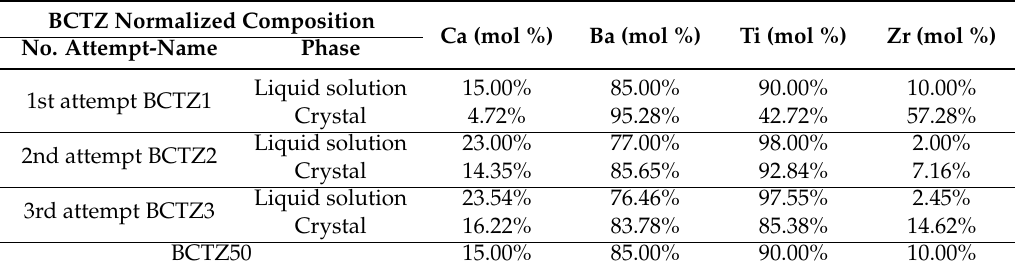
Table 3. Normalized liquid and crystal compositions of (1 ´ x )BaTi 0.8 Zr 0.2 O 3 ´ x Ba 0.7 Ca 0.3 TiO 3 (BCTZ) growth